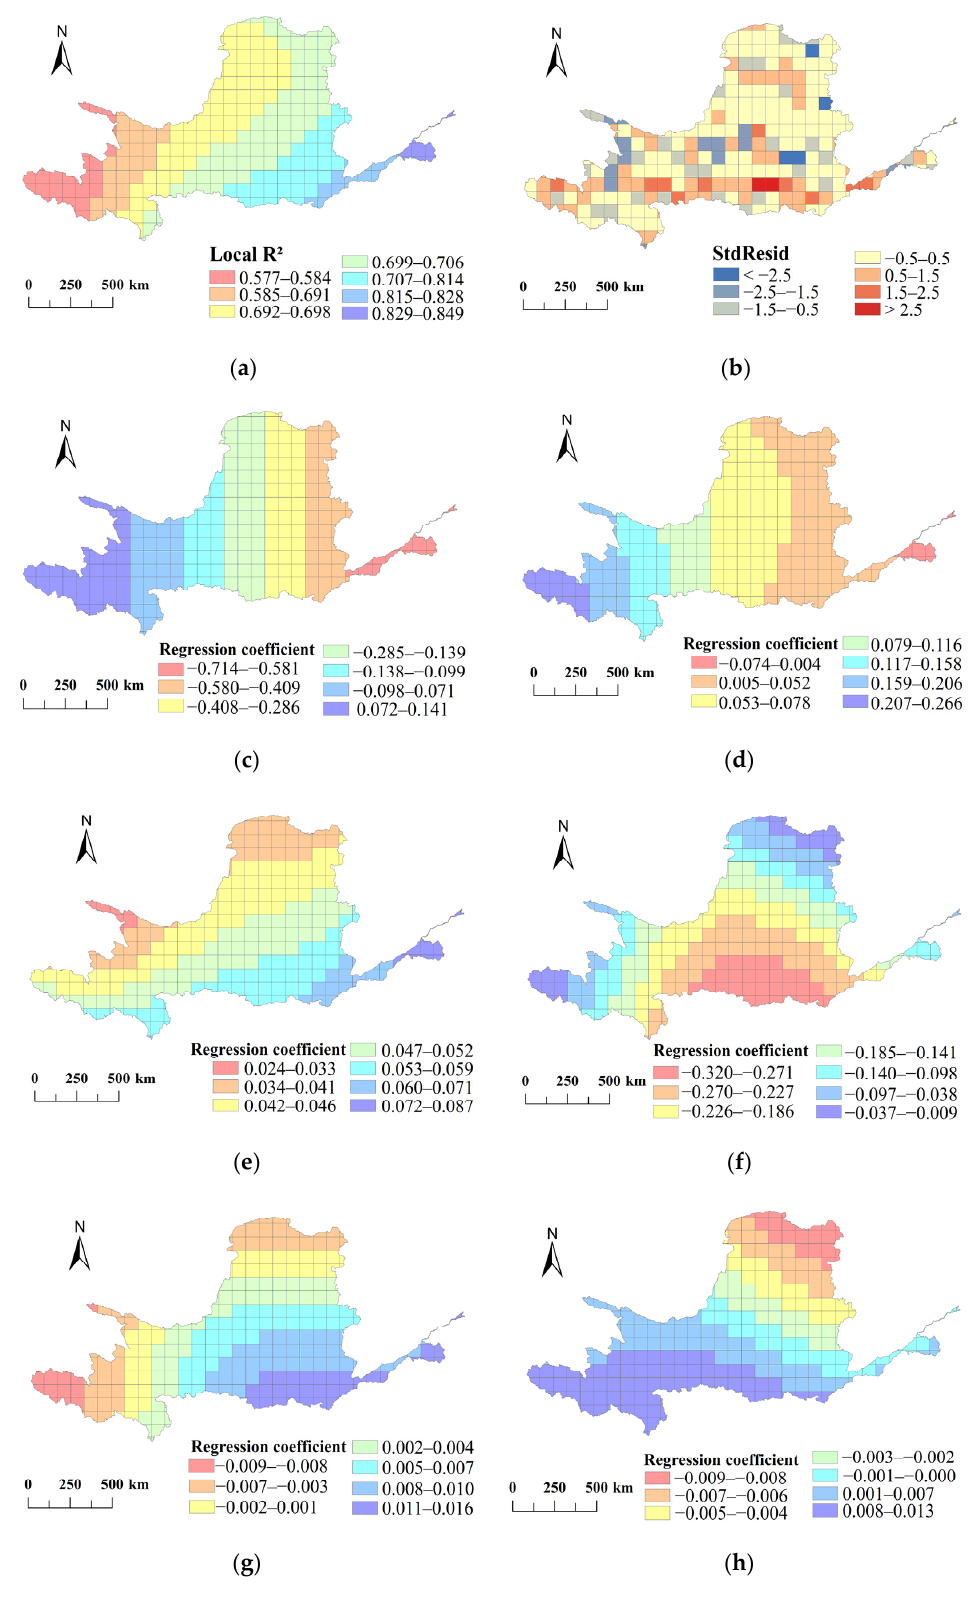
Figure 3. Influence degree of topography on river network structure at the 80 km analysis scale. ( a ) Local 𝑅 (cid:2870) ; ( b ) Standardized residual of the coefficient; ( c ) The width of the multifractal spectrum; ( d ) The difference in the multifractal spectrum; ( e ) Slope; ( f ) Average elevation; ( g ) Elevation maximum; ( h ) Elevation minimum. Figure 4 shows the degree of influence and spatial variation of different topographic factors on the river network structure at a 40 km analysis scale. It can be declared from Figure 4c that multifractal spectrum width was negatively correlated with river network structure in all analysis units, indicating that topographic complexity had a negative effect on river network structure at this analysis scale, and its effect increased gradually from southwest to northeast, showing significant spatial differences. The influence of the mul- tifractal spectrum height difference on the river network structure was small and negative; its influence degree increased gradually from west to east, and the spatial difference was small, indicating that the number and distribution of the probability subset of terrain